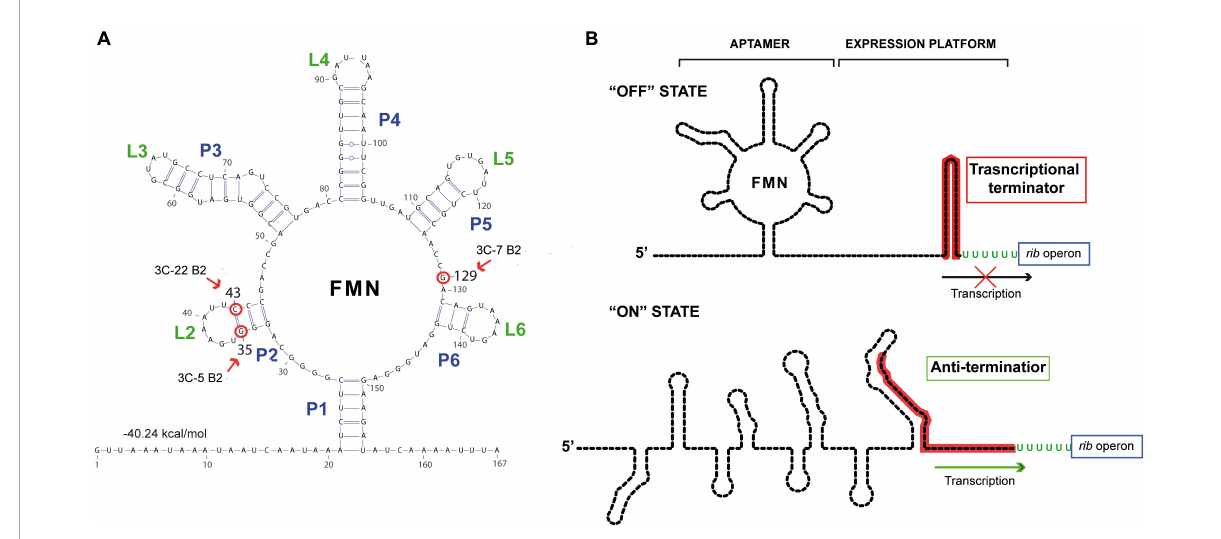
FIGURE2 Secondary structure predictions of the riboswitch domains. (A) Secondary structure prediction obtained by using RNAfold web server with the sequence of the nascent rib operon mRNA of Weissella cibaria BAL3C-5. The free energy associated with this aptameric conformation is shown. Red arrows and red circles indicate altered ribonucleotides in the aptamer in BAL3C-22 B2 (U at position 43), BAL3C-5 B2 (U at position 35) and BAL3C-7 B2 (A at position 129) due to the mutations present in the DNA of these strains. The strain containing the base change is indicated in each case. (B) Schematic representation of the possible “ON” and “OFF” conformations of the FMN riboswitch. The FMN riboswitch mechanism of gene expression is based on ligand binding and signal transduction through conformational changes from the “ON” state (anti-terminator structure) to the “OFF” state (transcriptional terminator). Aptamer and expression platform domains are indicated over the “OFF” state structure. The sequence involved in the formation of the transcriptional terminator is red colored. Arrows indicate transcription of the rib